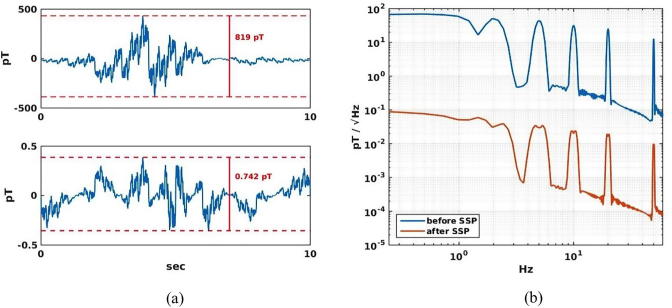
Rejection of external magnetic disturbance. (a) External noise field before (top) and after (bottom) SSP. (b) The same noise field presented in frequency domain.